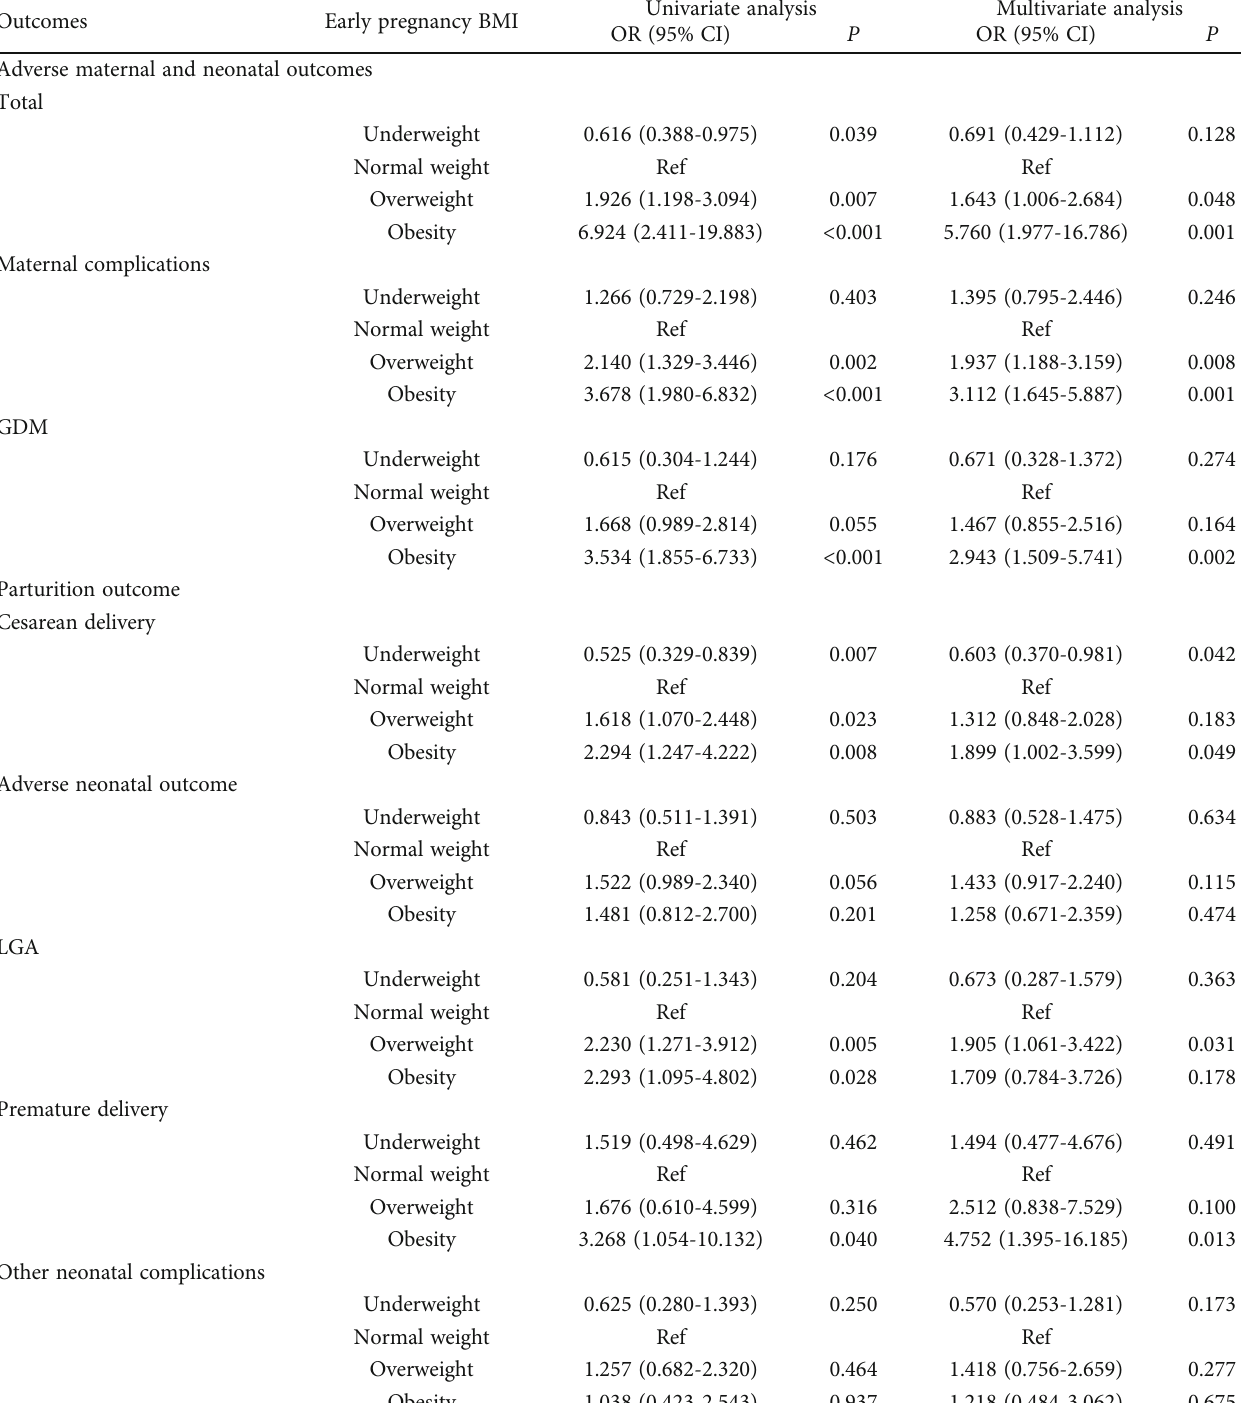
Table 3: BMI in early pregnancy on maternal and neonatal adverse